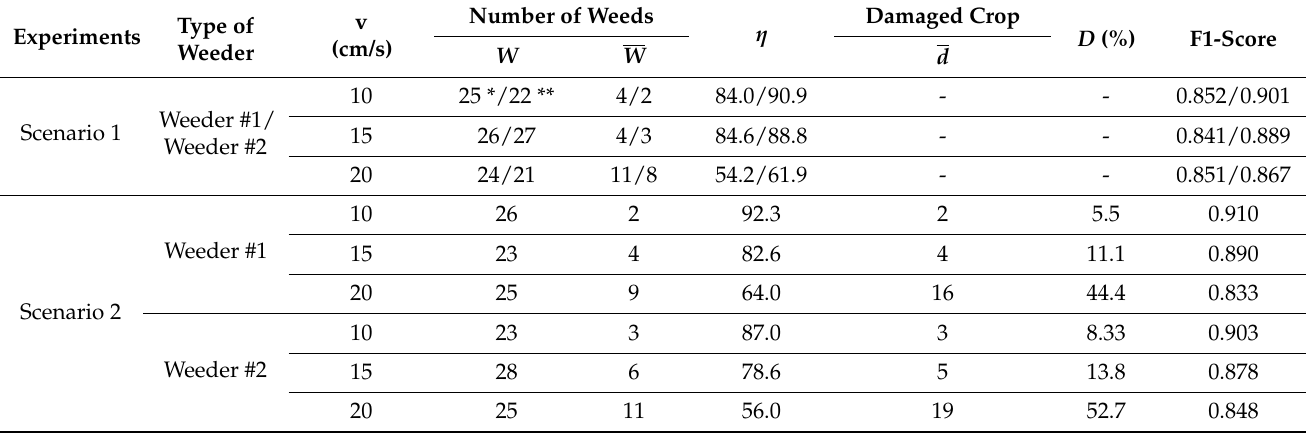
Table 4. Performance evaluation results of the weeding system.